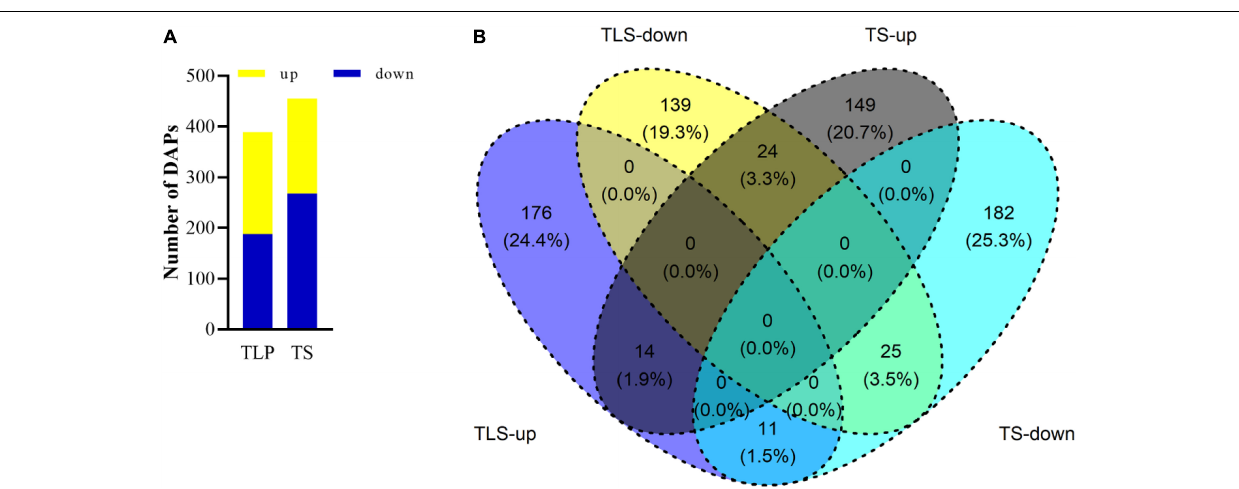
Wave m/z = 25 ppm, peak width = c (10, 60), prefilter = c (10, 100). For peak grouping, bw = 5, mz wid = 0.025, minfrac = 0.5 were used. Metabolite structure identification